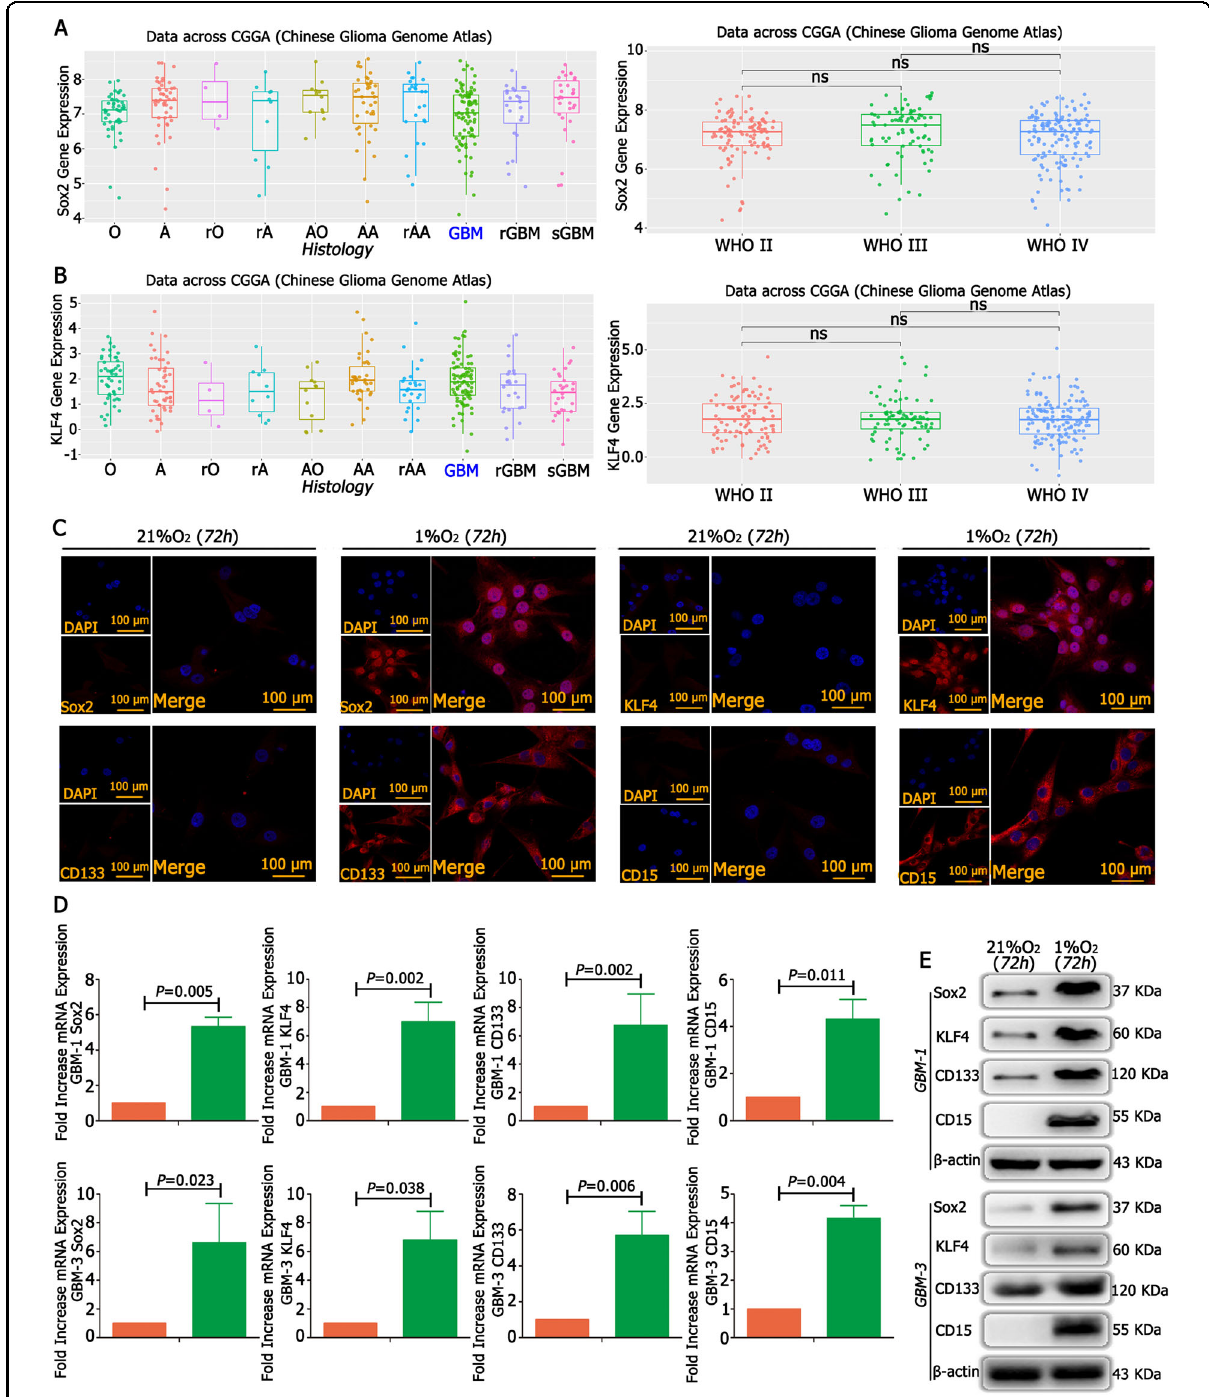
Fig. 5 Sox2, Klf4, CD133 and CD15 were expressed in GBM under hypoxia. A , B Assessment of samples from the CGGA database showed that Sox2 and Klf4 were expressed in GBM. C GBM cells exposed to 21% O 2 and 1% O 2 for 72 h showed that Sox2, Klf4, CD133 and CD15 levels increased signi fi cantly in 1% O 2 when compared with control cells in 21% O 2 . D , E There was a lower expression of Sox2, Klf4, CD133 and CD15 under normoxia, while these proteins increased signi fi cantly under hypoxic conditions. P values were determined by the independent samples t